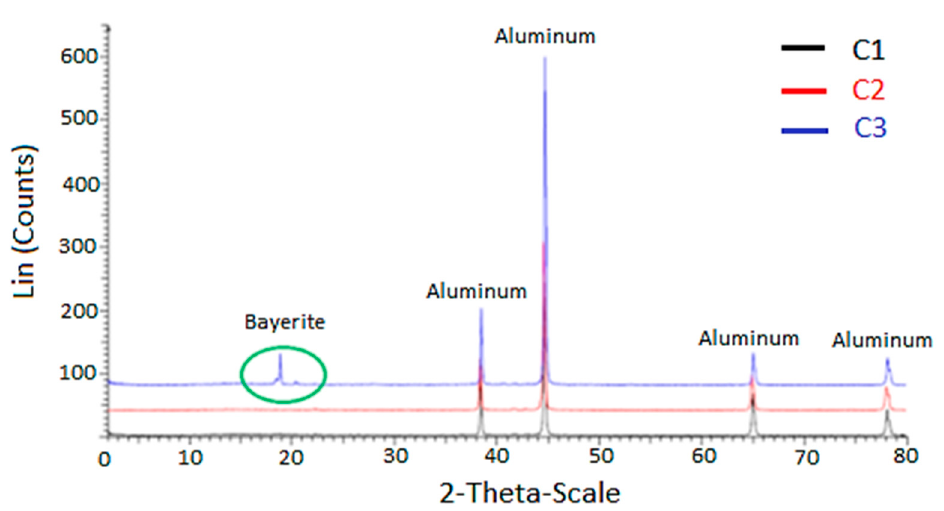
Figure 5. X-ray diffraction analysis of corrosion products where a bayerite [ β -Al(OH) j . 3H2O] peak can be seen in the sample corroded for 3 months.